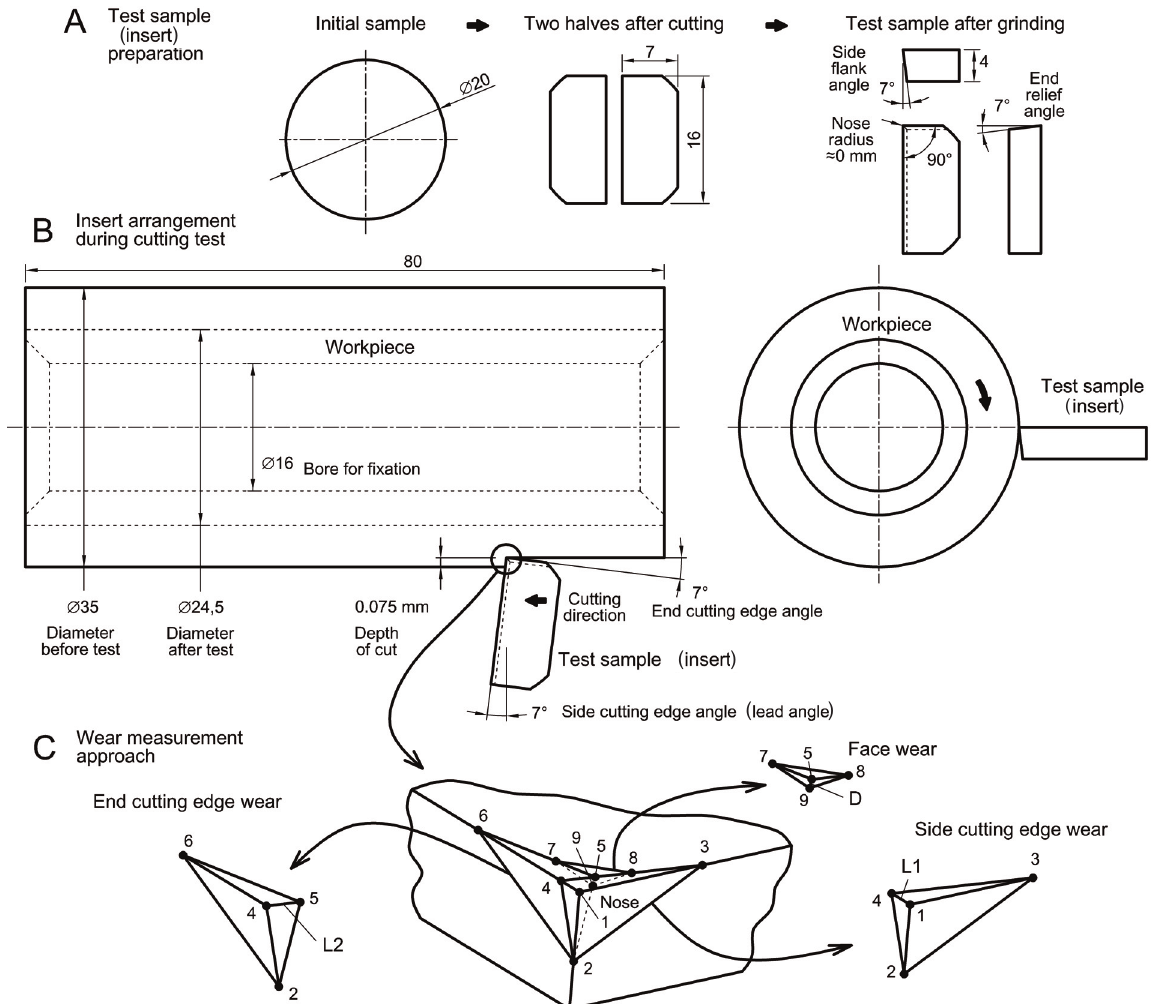
Fig. 1. The sample (insert) preparation (A), its arrangement during the cutting test (B) and the wear rate measurement approach